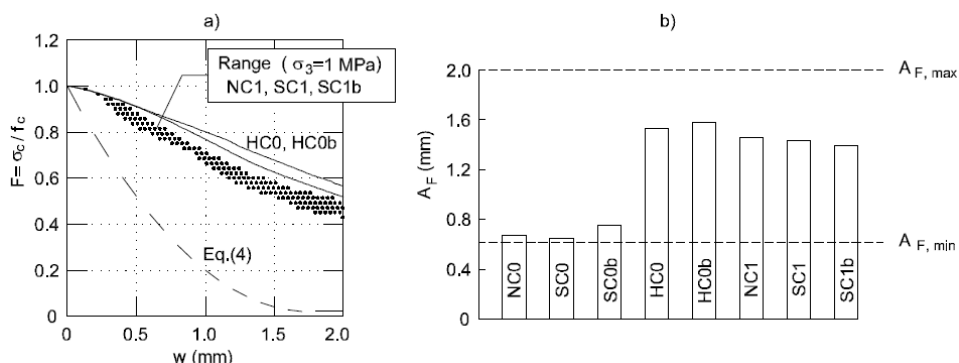
Figure 7: The post peak behaviour in terms of F ( w ).